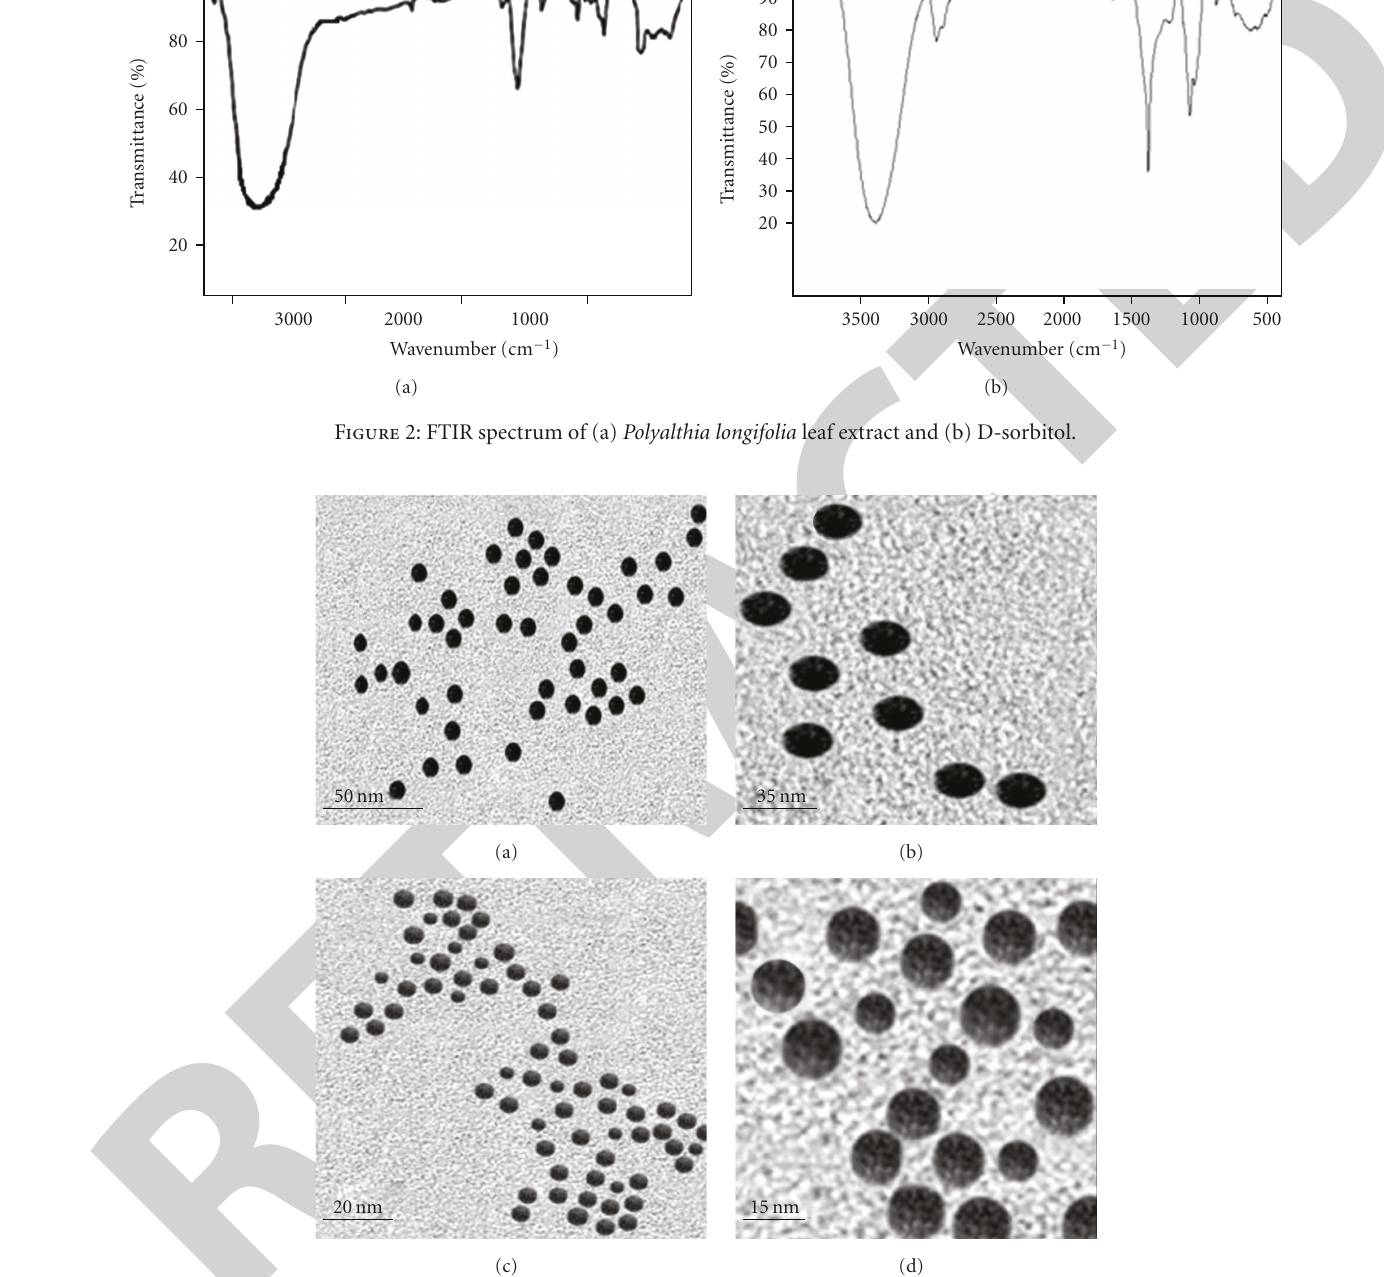
Figure 3: HRTEM image of the biosynthesized silver nanoparticles showing various particle sizes at (a and c) 25 ◦ C, (b and d) 60 ◦ C.